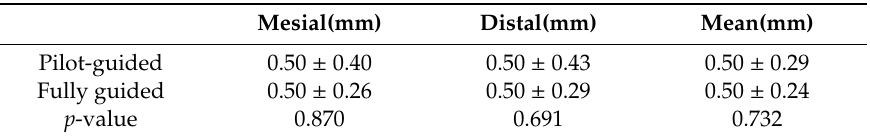
Table 5. Marginal bone loss after 1 year (Mean ± S.D.).